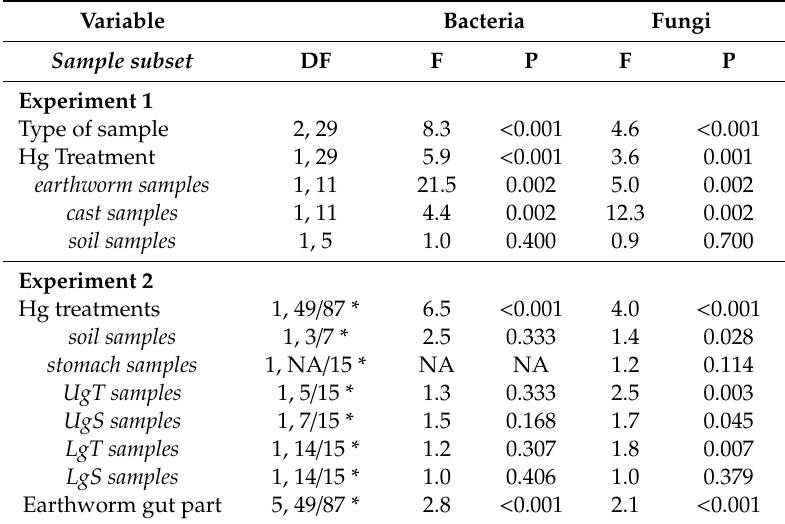
Figure 3. Beta diversity of the bacterial ( A ) and fungal ( B ) communities in experiment 1, presented in a non-metric multidimensional (NMDS) ordination including the three sample types (earthworm, cast and soil) and the two treatments (uncontaminated and Hg-contaminated). Table 3. Statistical di ff erences (ANOVA) in bacterial and fungal beta-diversity between Hg treatments and among sample types in experiment 1 and between Hg treatments and among earthworm gut parts in experiment 2. DF = Degrees of